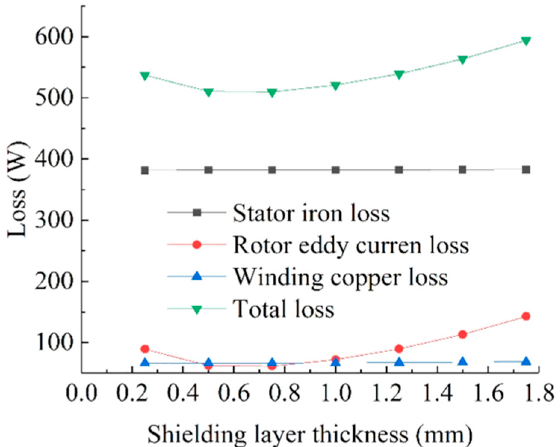
Figure 18. Comparison diagram of motor loss with different shielding-layer thicknesses at − 196 °C.